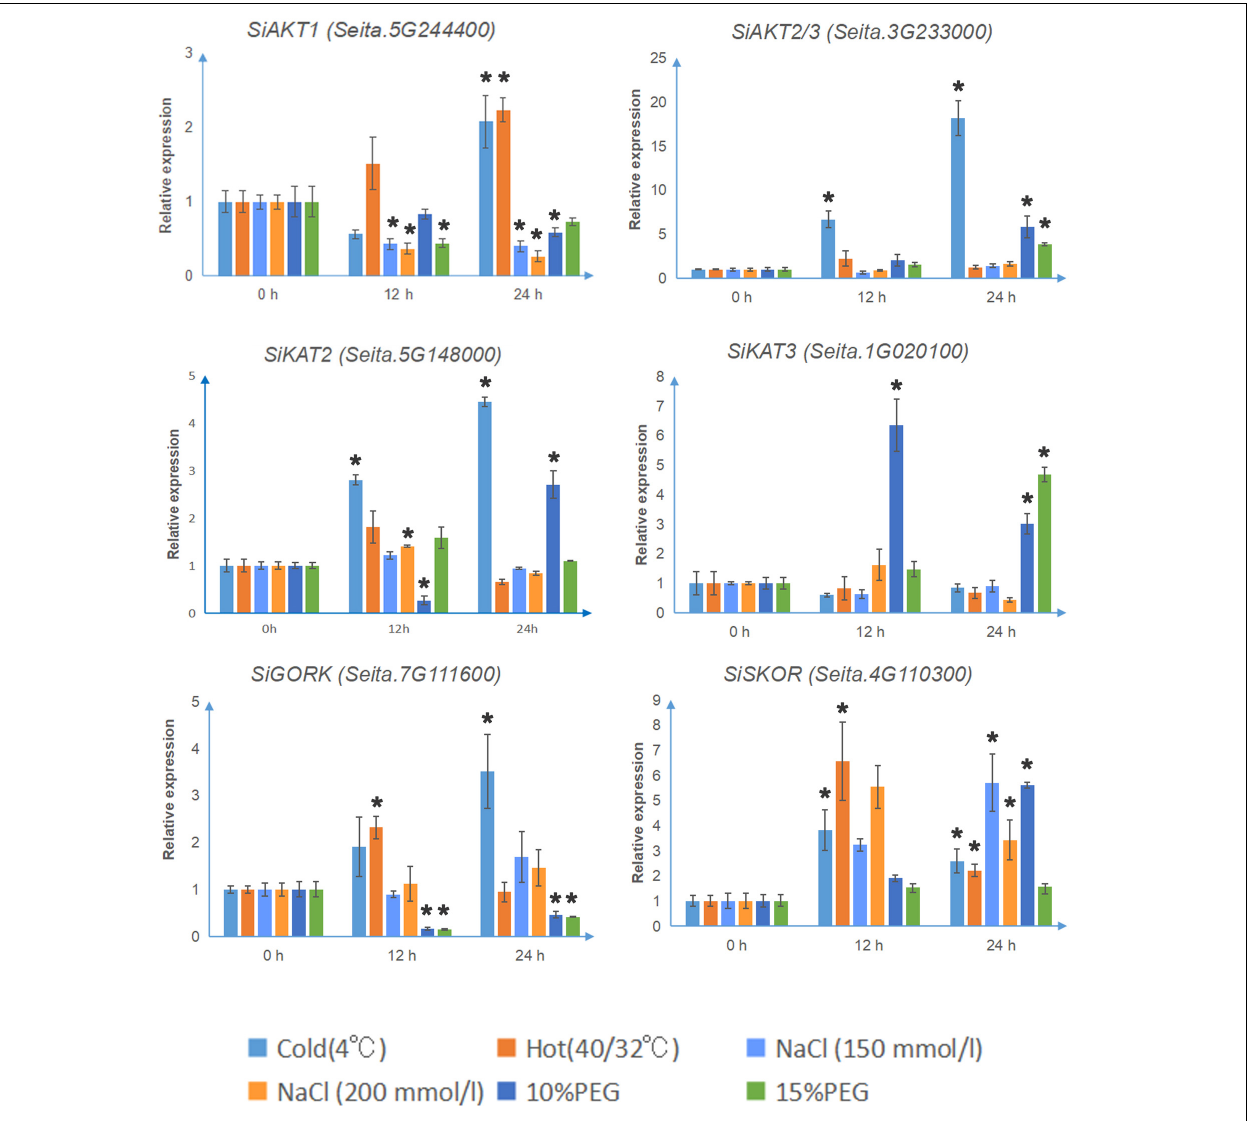
FIGURE 4 | The relative transcript levels of Shaker K + channel genes in foxtail millet under different abiotic stresses. The qRT-PCR analyses were used to access transcript levels of Shaker K + channel genes from foxtail millet with or without 12 and 24 h cold (4 ◦ C), hot (40 ◦ C day/32 ◦ C night), salt (150 mmol/l, 200 mmol/l NaCl), and osmotic stress (10 and 15% PEG) treatments. Each bar represents the mean ± SE normalized to SiAct2 (Seita.8G043100) . All samples were run in three biological and three technical replicates. Asterisk indicates that the gene expression under stress has a significant difference compared with the control at 0 h (* p <